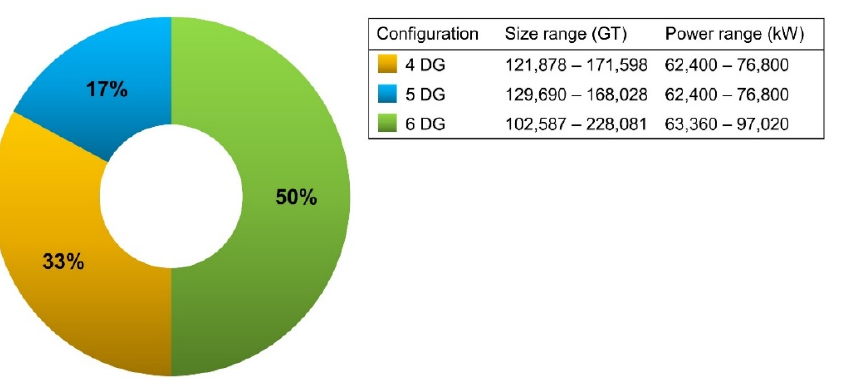
Figure 2. Conventional power plant configurations for large diesel-electric cruise